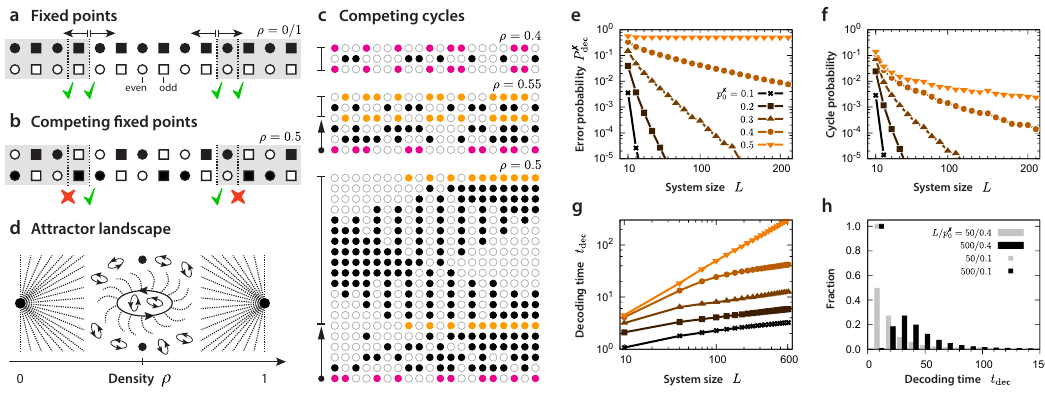
Figure 5: Properties of TLV . a The homogeneous fixed points of TLV with minimum / maximum filling ρ = 0 / 1 correspond to the syndrome-free states of the quantum code. The eroder prop- erty makes them stable in that (small enough) perturbations are erased and do not proliferate. b Two of four additional fixed points of TLV are inherited by TLV if the leftmost / rightmost site are labeled by even / odd indices (check marks). Those are characterized by a critical filling ρ = 0.5. c Three examples of random initial configurations (magenta) which relaxed into cy- cles of various lengths. The first recurring configurations are highlighted with the same color to separate the cycle from the relaxation path. We find only cycles close to criticality with ρ ≈ 0.5. d Sketch of the state space with dashed attractor paths, based on the results in a-c . The two homogeneous fixed points are attractors of all states away from criticality; this moti- vates the application of TLV as decoder. e Numerical results for the probability of